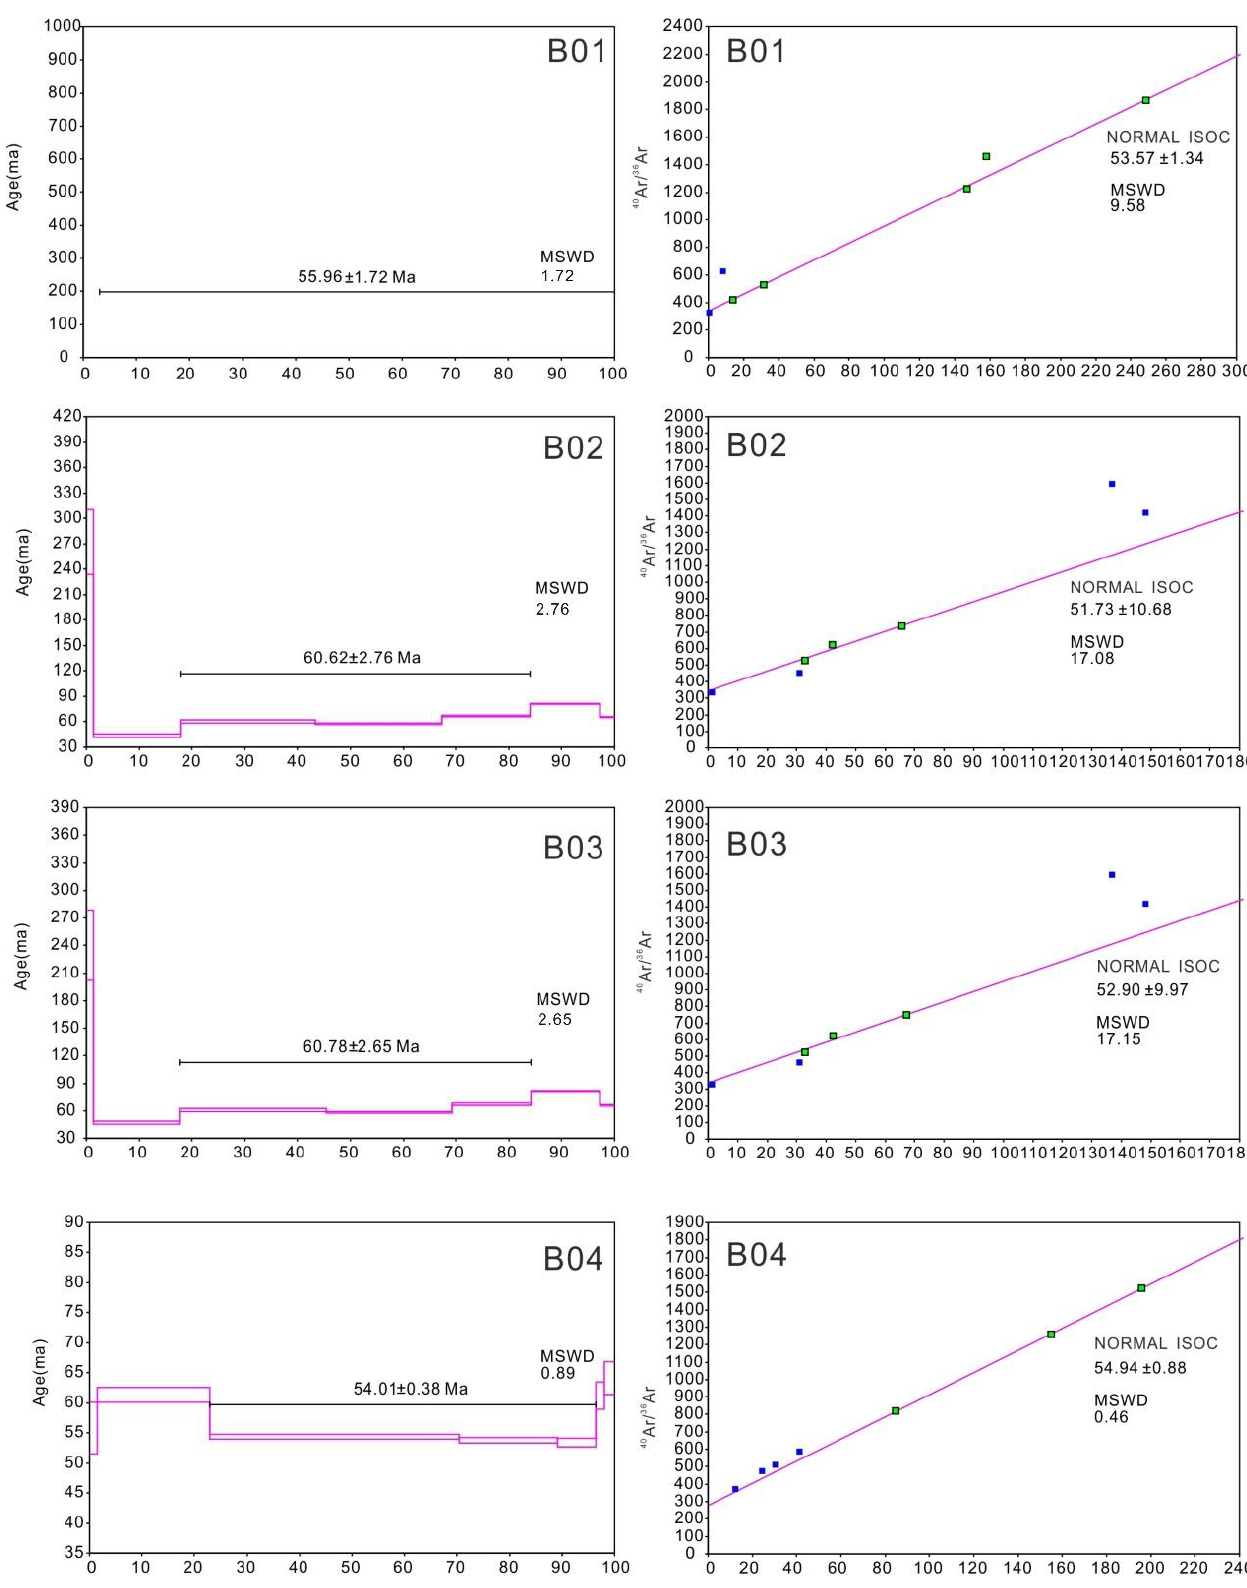
Figure 7. 40 Ar/ 39 Ar age spectra and isochron ages (Sample B01 – B04) of the volcanic rocks from the Jiangling Basin.